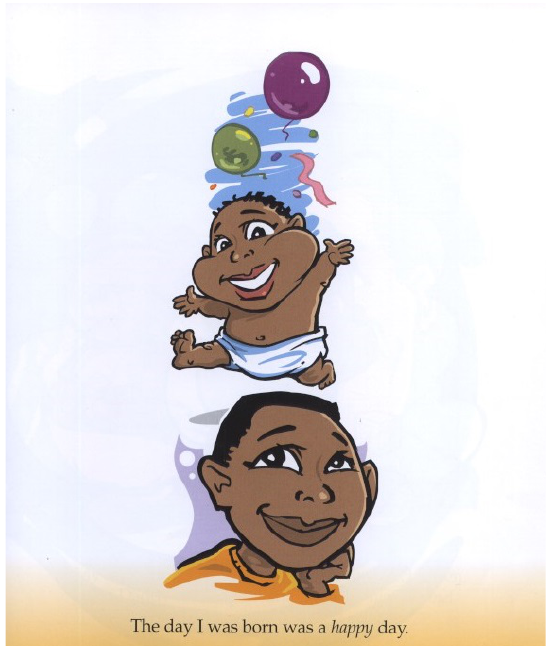
Figure 3. The picture book is presented as the adoptee’s own retrospective narration.